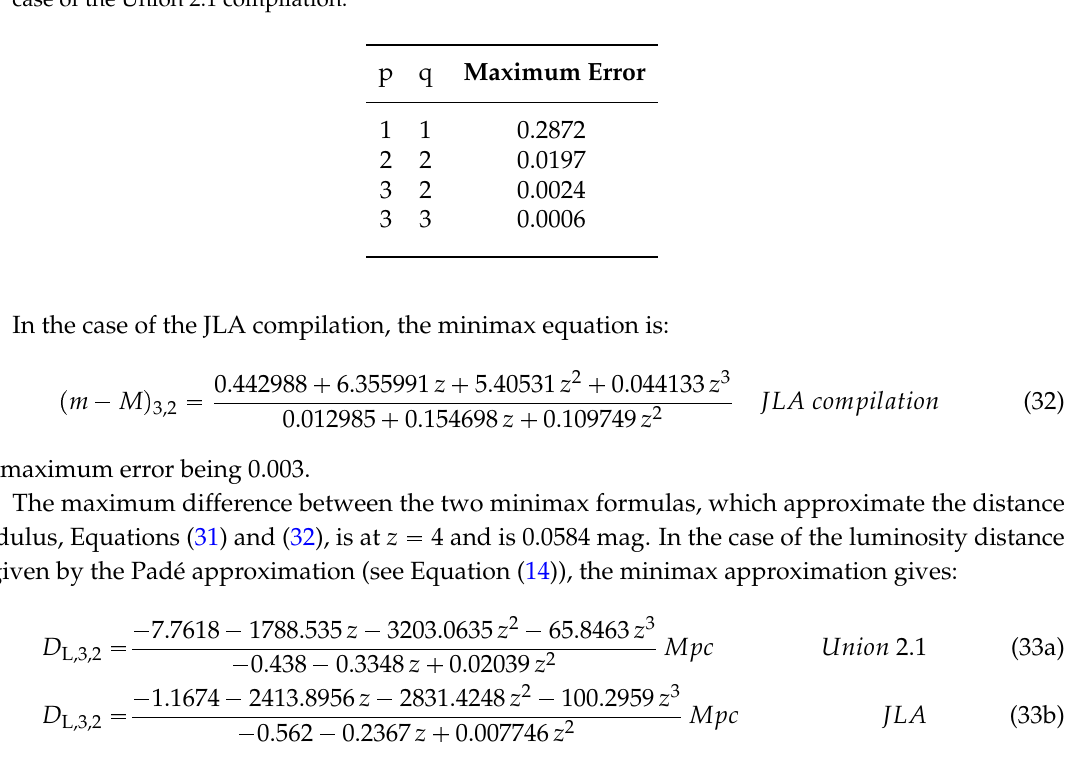
Table 2. The maximum error in the minimax rational approximation for the distance modulus in the case of the Union 2.1